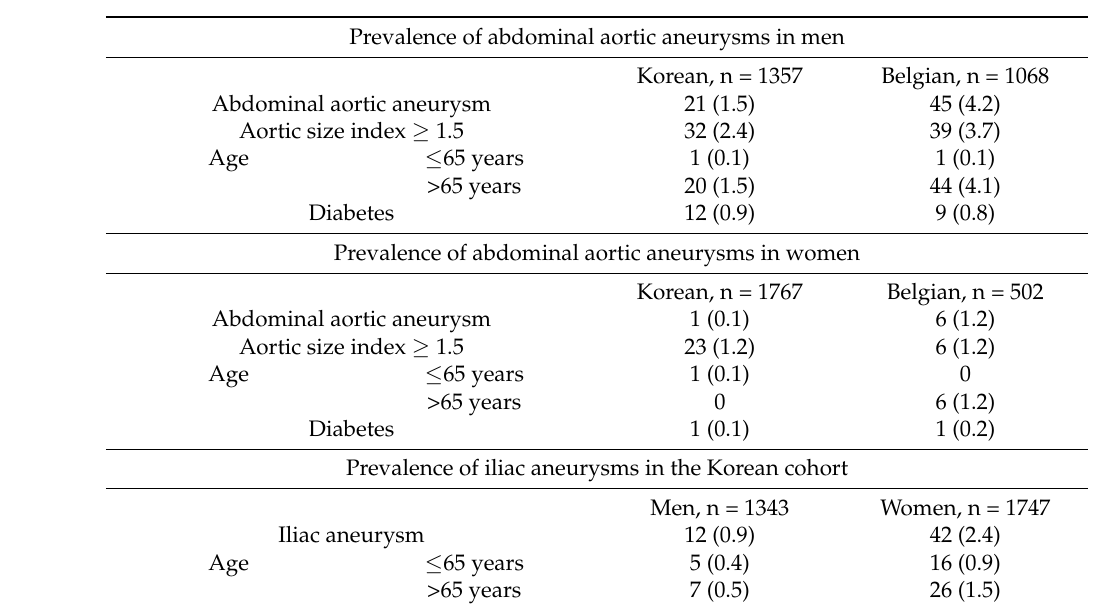
Table 2. Prevalence of abdominal aortic and iliac artery aneurysms in the Korean cohort and abdomi- nal aortic aneurysms in the Belgian cohort.